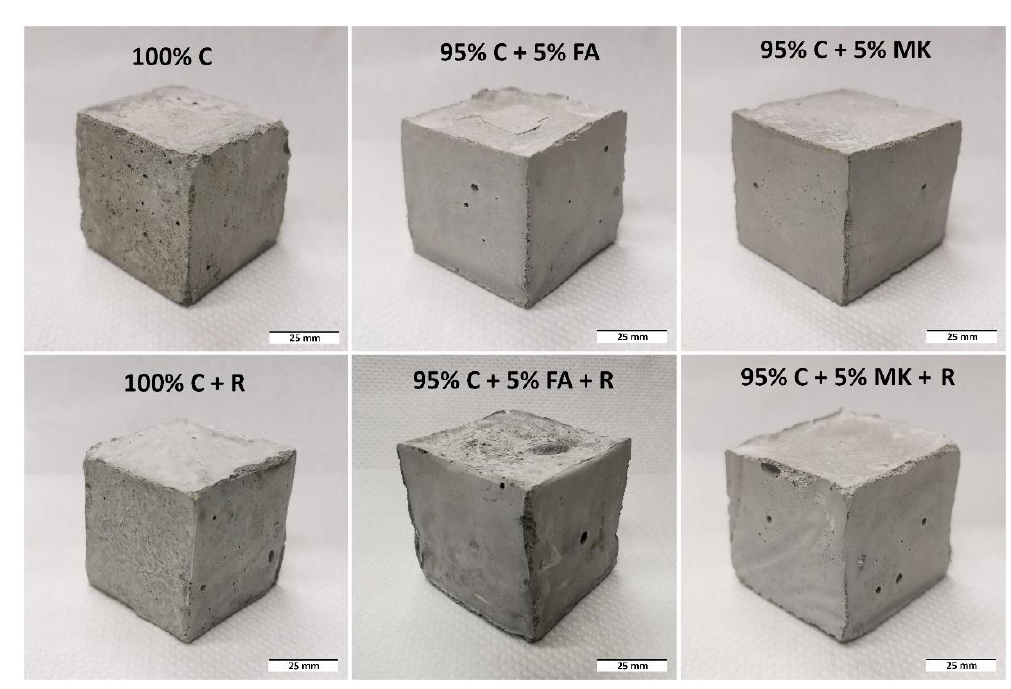
Figure 2. Representative view of the samples produced by casting.